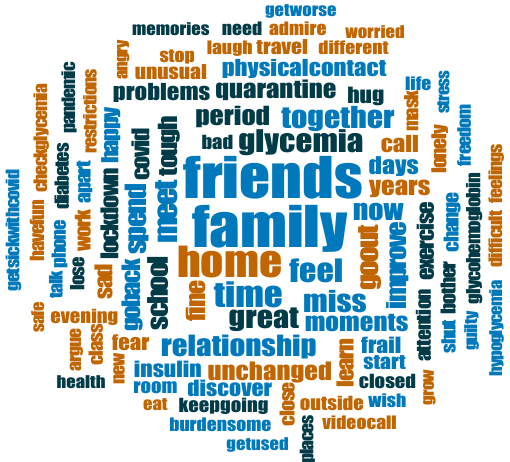
Figure 1. Top 100 most referred words in adolescents’ narratives.